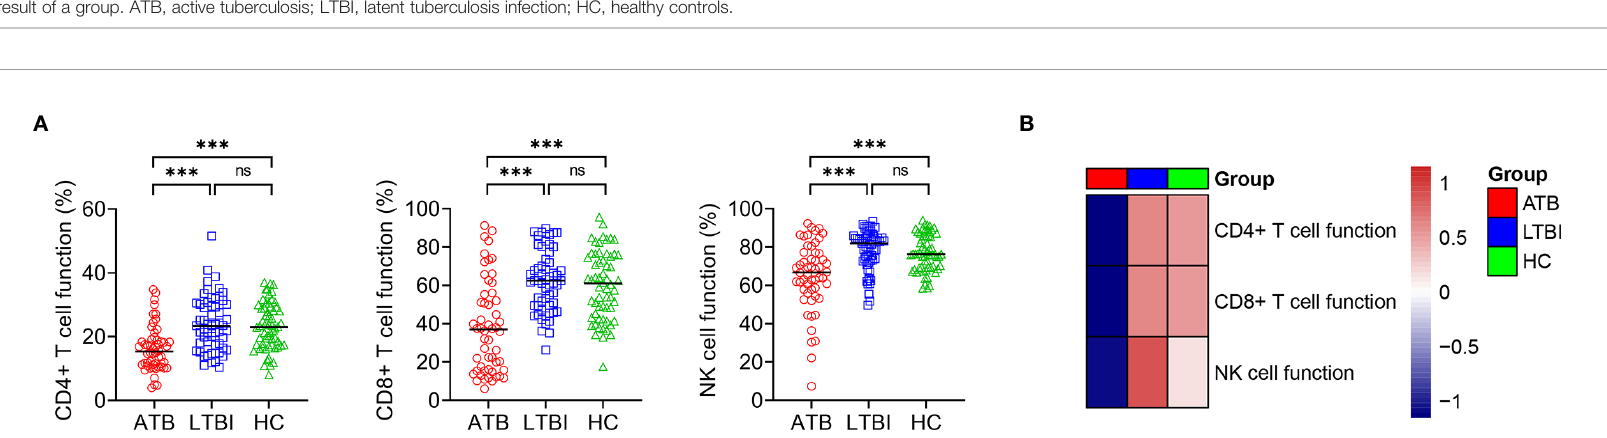
FIGURE 4 | The results of lymphocyte function in ATB, LTBI, and HC. (A) Scatter plots showing the results of lymphocyte function in ATB (n = 54), LTBI (n = 57), and HC (n = 60). Horizontal lines indicate the median. *** P < 0.001, ns, no signi fi cance (Mann-Whitney U test). (B) Heatmap showing the results of lymphocyte function in ATB group, LTBI group, and HC group. Each rectangle indicates the median result of a group. ATB, active tuberculosis; LTBI, latent tuberculosis infection; HC, healthy